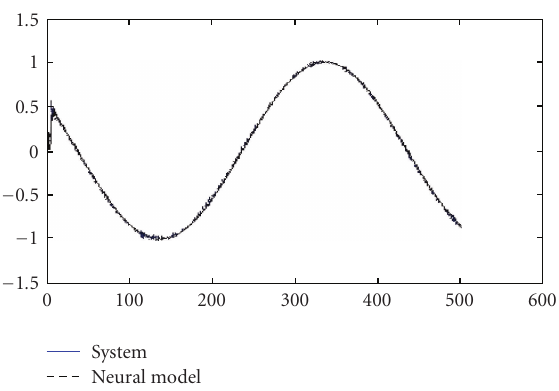
Figure 6: Evolution of the system output and the neural model output ( ε ∈ stability